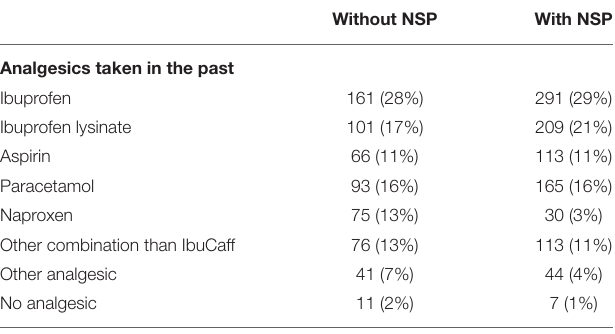
TABLE 3 | Analgesics taken in the participants’ headache